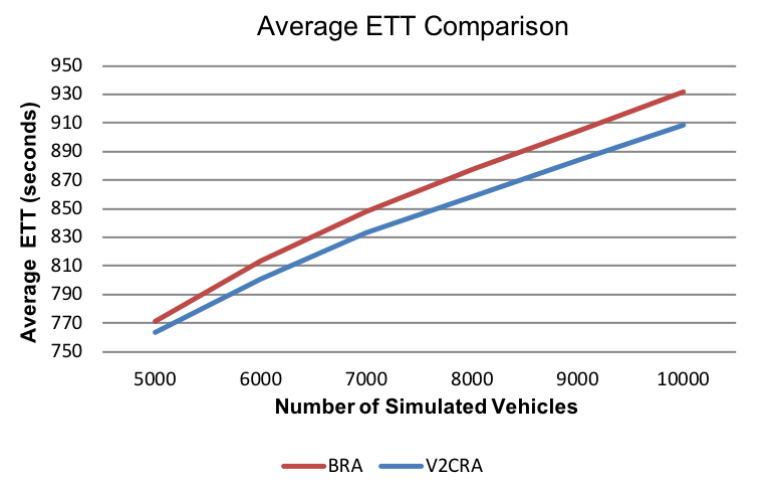
Figure 20. Average ETT for BRA vs.